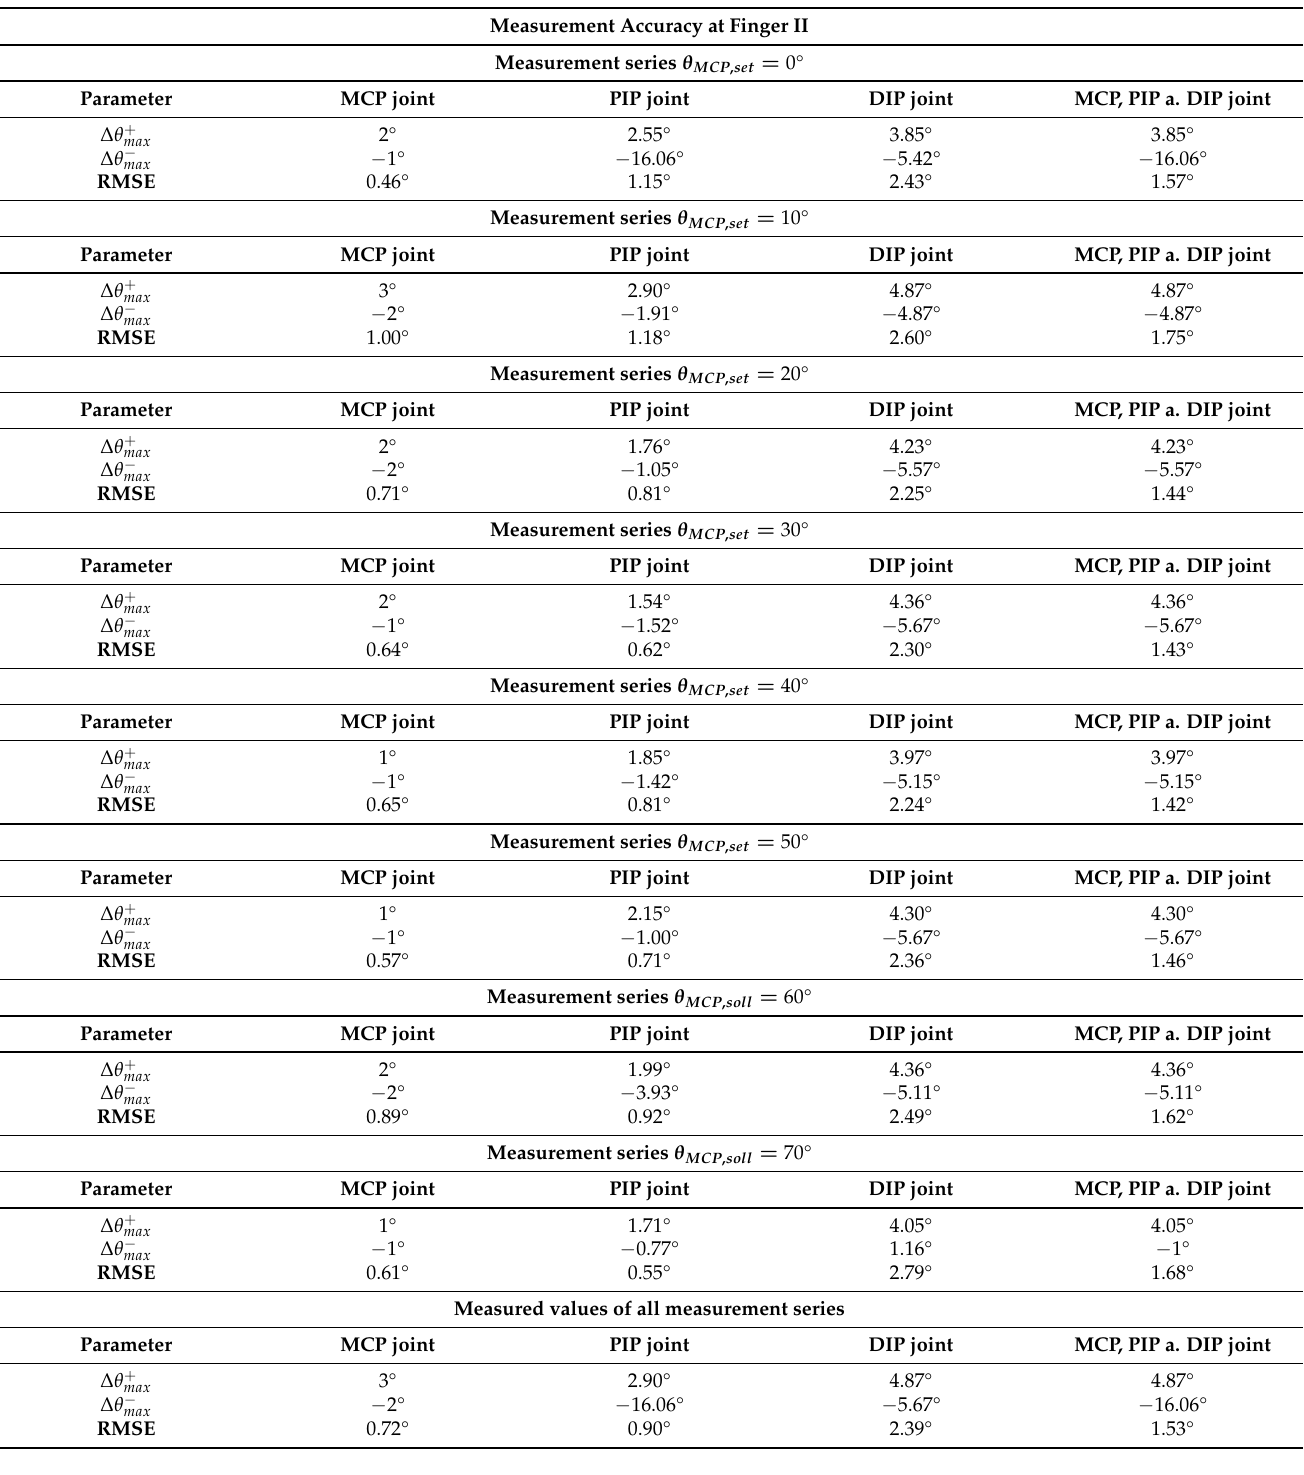
Table A9. Results of the measurement series on the measurement accuracy of the joint angles of finger II. Measurement series sorted in dependence on the predetermined angle θ MCP , set for the Metacar- pophalangeal joint. Results shown are the maximum positive ∆ θ + max and negative ∆ θ − max deviations, as well as the root-mean-square error (RMSE). Joints: Distal Interphalangeal (DIP), Metacarpophalangeal (MCP), Proximal Interphalangeal